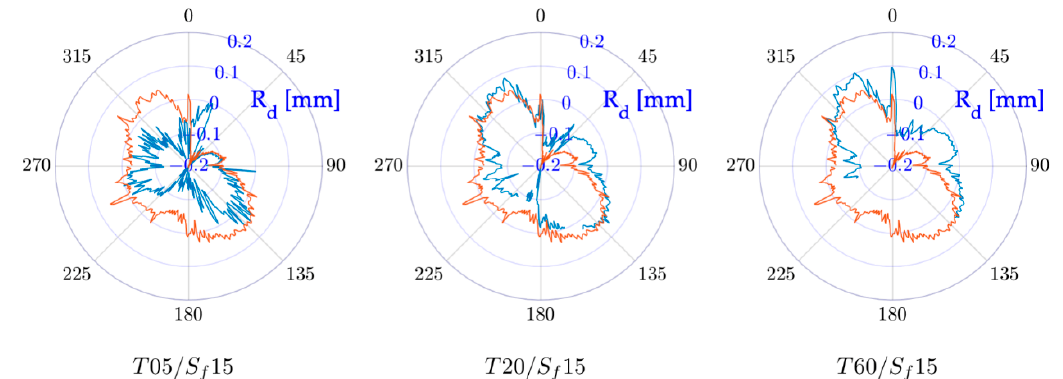
Figure 16. Polar graphs of R d calculated for S 03 including reference CMM data (red dots) and three different test conditions (blue dots).